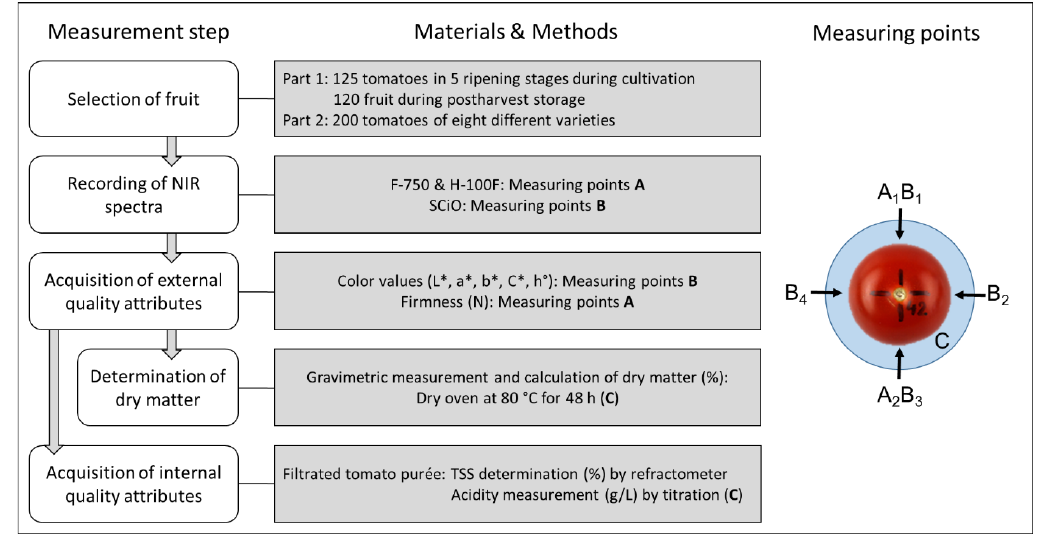
Fig. 2: Illustration of the measurement procedure and measuring points for NIR spectra as well as quality parameters within this